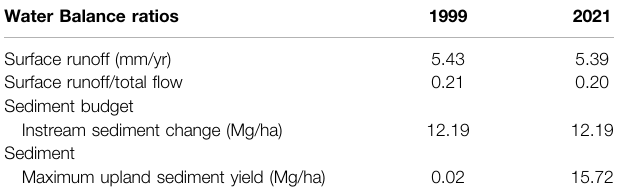
TABLE 7 | SWAT results for the Š tavska River watershed.